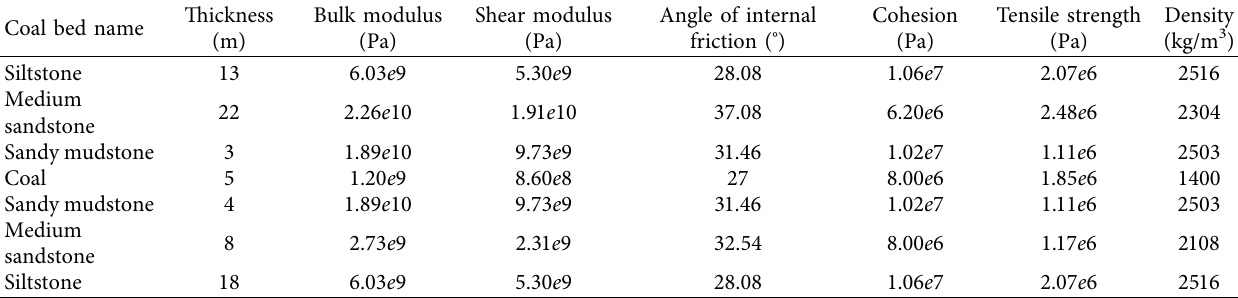
Table 1: Table of physical and mechanical parameters of coal strata.